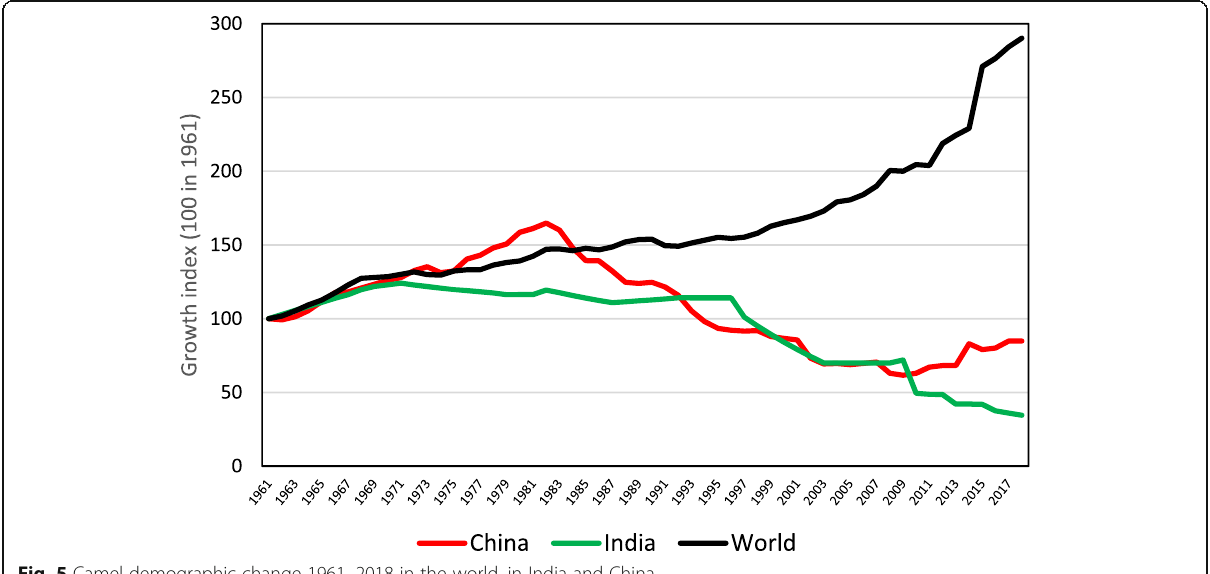
Fig. 5 Camel demographic change 1961 – 2018 in the world, in India and China